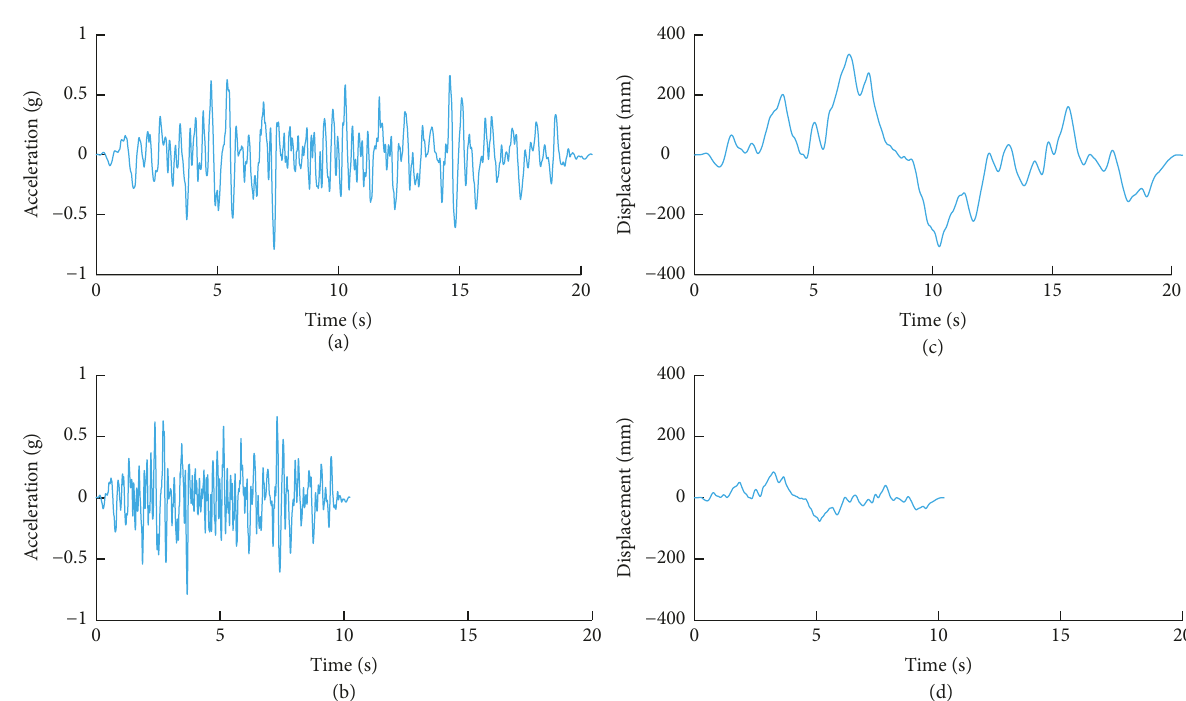
Figure 7: Ground excitation. ((a) and (c)) original and ((b) and (d)) scaled time